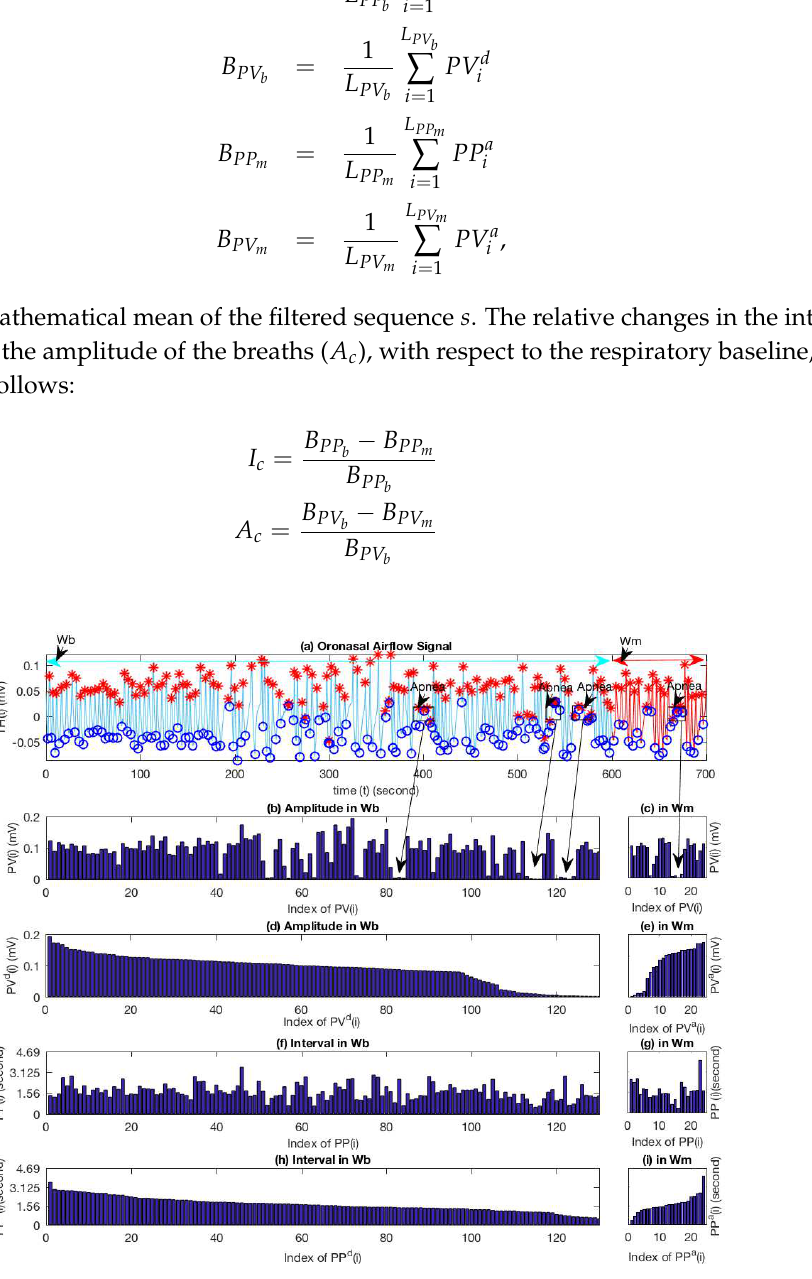
Figure 1. ( a ) Oronasal respiration signal with peak/ valley detections illustrated by (red ‘*’)/ (blue ‘o’) respectively. ( b ) Sequence of extracted breath amplitudes of W b . ( c ) Sequence of extracted breath amplitudes of W m . ( d ) PV b Sequence of descending ordered amplitudes in W b . ( e ) PV m Sequence of ascending ordered amplitudes of W m . ( f ) Extracted inter-breath intervals of W b . ( g ) Extracted inter-breath intervals of W m . ( h ) PP b sequence of descending ordered inter-breath intervals of W b . ( i ) PP m sequence of ascending ordered intervals of W m . Annotations in subplot ( a ) illustrate example of apnea events present in W b , W m . Arrows point to the breath amplitudes from apnea events shown in W b , W m